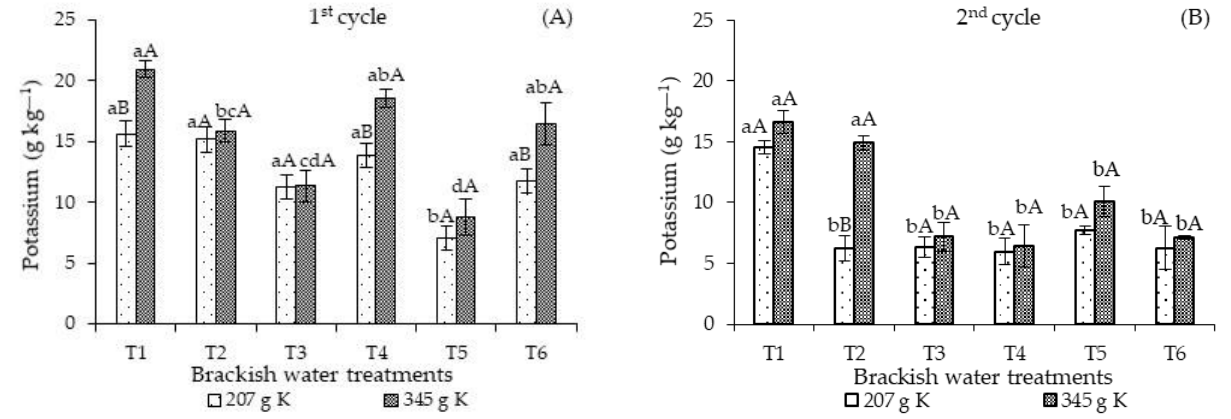
Figure 3. Leaf K concentrations of Passiflora edulis Sims as a function of the interaction ISBW × KD in the first ( A ) and second ( B ) cycle. Standard error of the mean ( n = 4); Means followed by different lowercase letters indicate a significant difference between irrigation strategies with brackish water for the same KD ( p ≤ 0.05), and different uppercase letters indicate a significant difference between potassium levels for the same irrigation strategy. T1—irrigation with low-salinity water during the entire cultivation cycle; salt stress in the following stages: T2—vegetative; T3—flowering; T4—fruiting; T5—vegetative and flowering; T6—vegetative and fruiting.